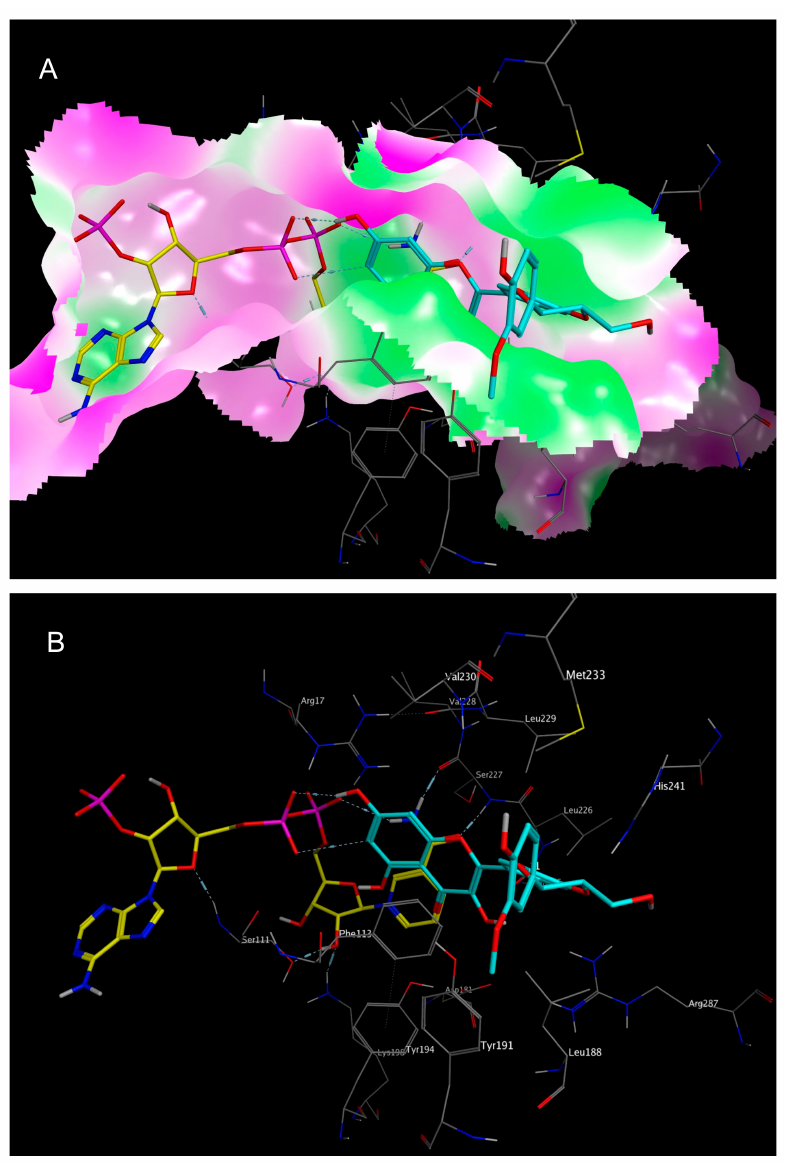
Figure 6. Best calculated docking pose of 2,3-dehydrosilybin A ( 1 ) in the folic acid binding site of Lm PTR1 (PDB-ID “2BFM”), with the co-crystallized NADP + shown in yellow, and the best docking pose of 1 shown in cyan. ( A ) The molecular surface of the binding site was colored according to lipophilicity, with green indicating high lipophilicity, and purple indicating low lipophilicity; ( B ) Surface not shown, but amino acid residues